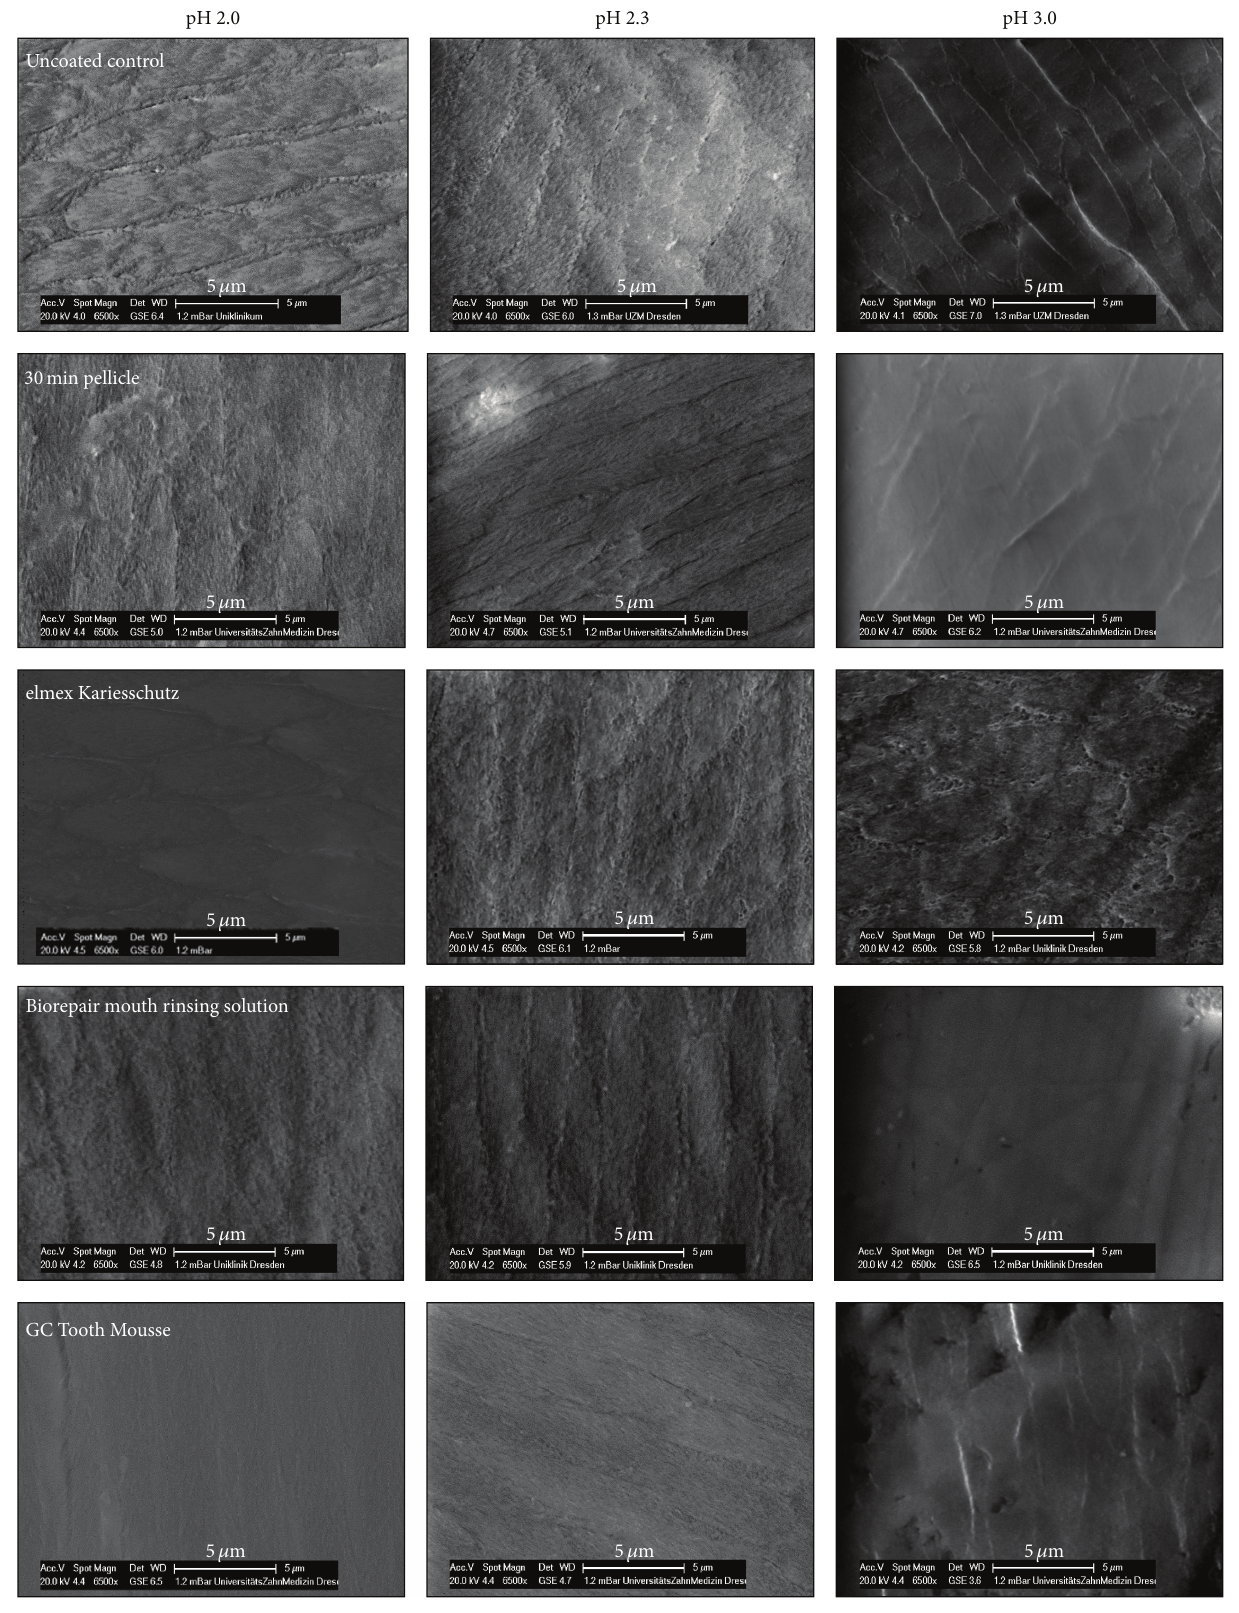
Figure 4: Incubation of enamel slabs in HCl for 60 s after pretreatment with different products in situ , scanning electron microscopic